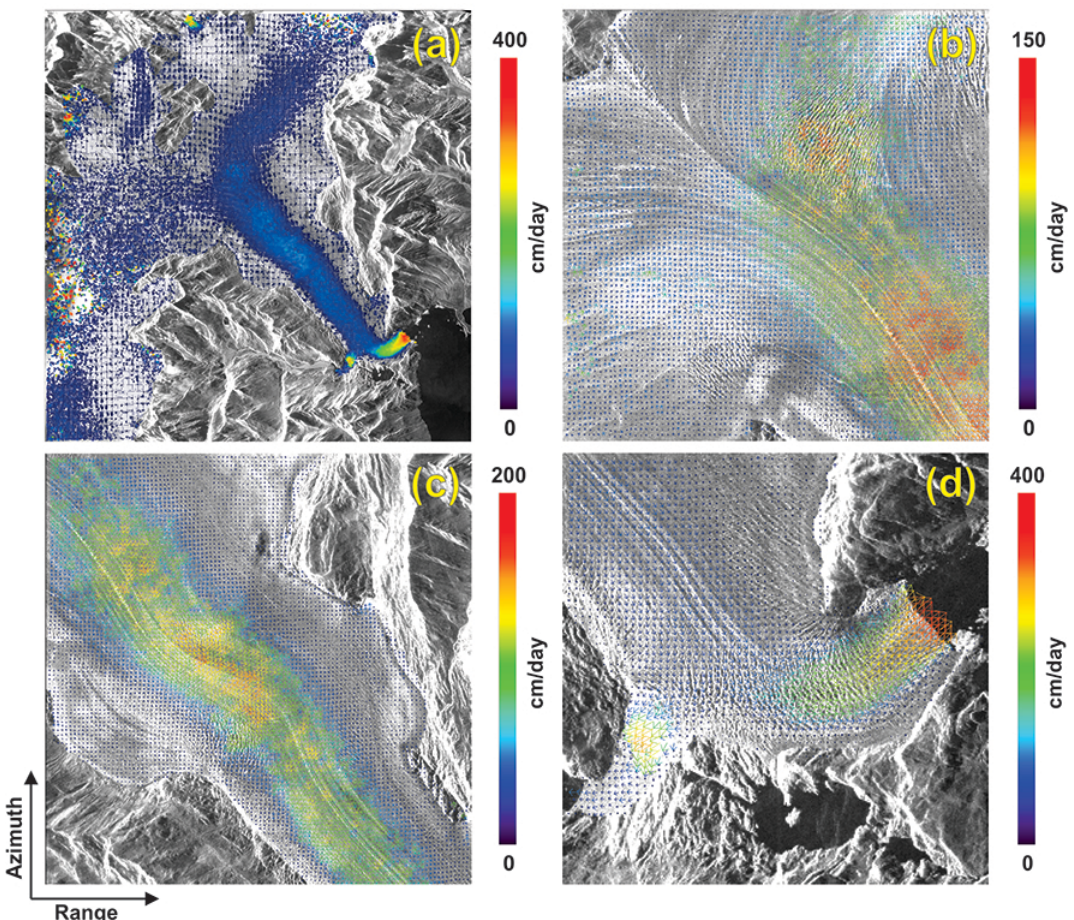
Fig. 5. Ice velocity field computed by Offset Tracking from COSMO-SkyMed ascending tandem pairs (15–16 June 2012). (a) shows the area indicated by the blue box in Fig. 1 and (b–d) are parts of the ice velocity map corresponding to the areas indicated in Fig. 4. (Note that the color bars are